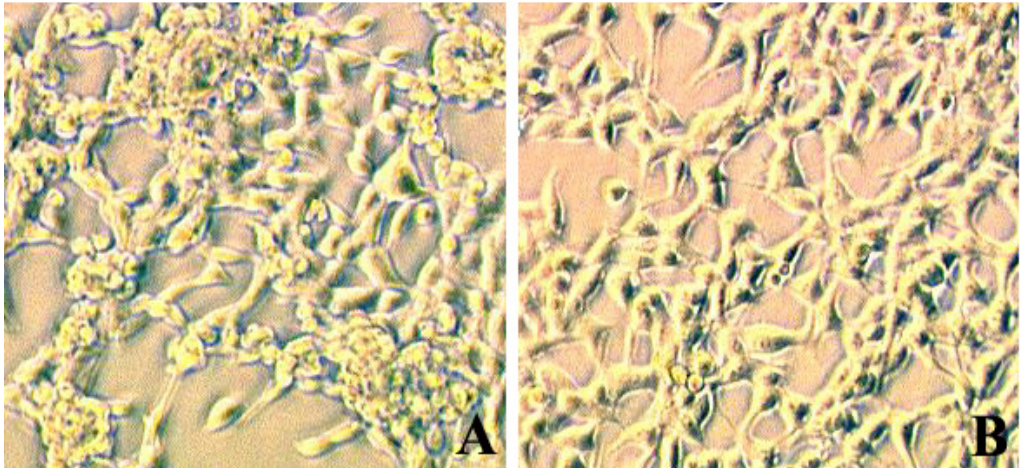
Figure 1. TRPV1 cells grown at 37 °C ( A ) and 33 °C ( B